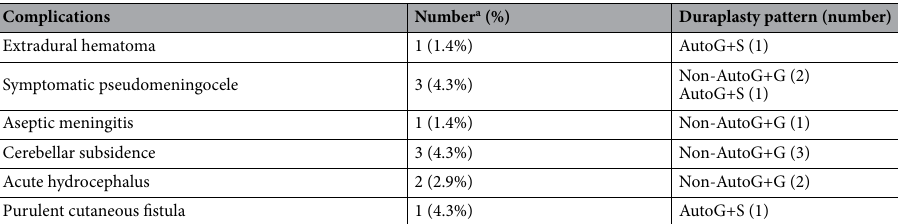
Table 5. Postoperative complications. a Seven (10%) patients had postoperative complications, with multiple adverse events in 3 of them: 1. cerebellar subsidence and large pseudomeningocele and acute hydrocephalus, 2. cerebellar subsidence and acute hydrocephalus, 3. cerebellar subsidence and large